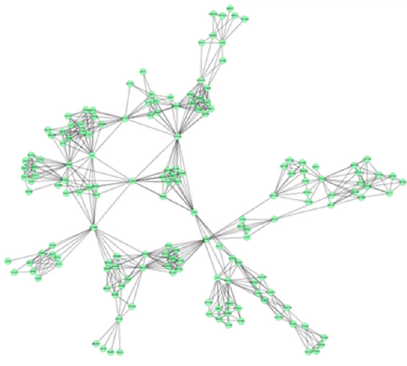
Figure 3. PIN of GTsbased on 19 frequency targets with 185 nodes (proteins) and 733 edges Figure 3. PINof GTsbased on 19 frequency targets with 185 nodes (proteins) and 733 edges (relations).